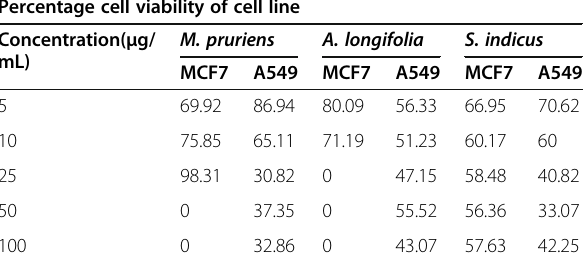
Table 2 Effect of M. pruriens , A. longifolia and S. indicus on mitotic index (MI) of Allium cepa root tip cells Treatments